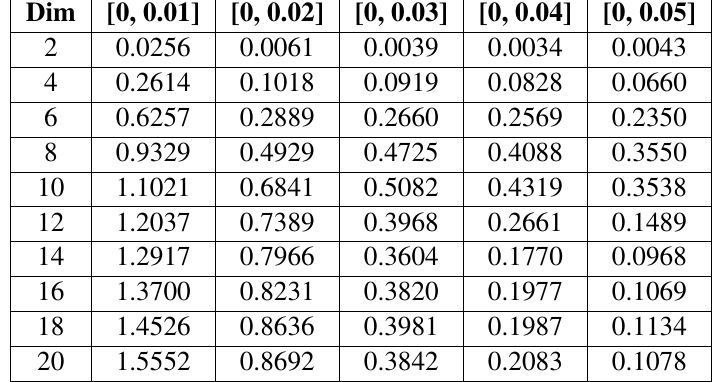
Table 3: Results on Griewank function from 2 dimensions to 20